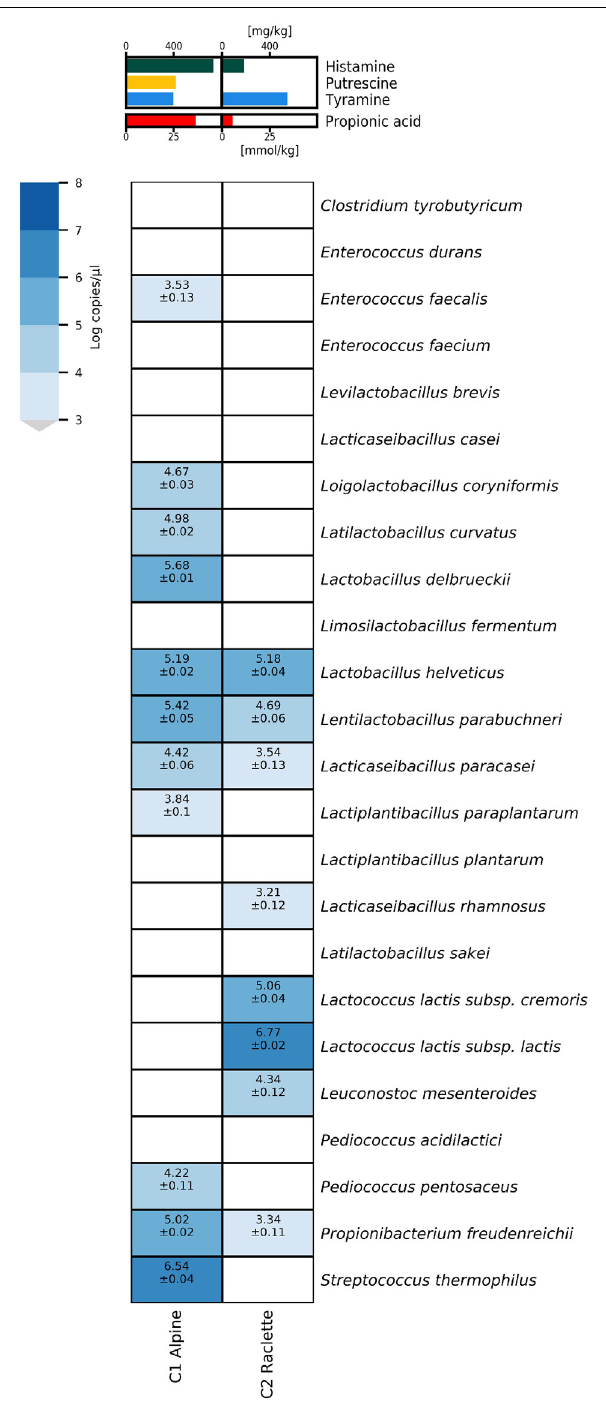
detection of species with lower abundancies (e.g., NSLAB species) in early stages of ripening could optionally be achieved using a preamplification